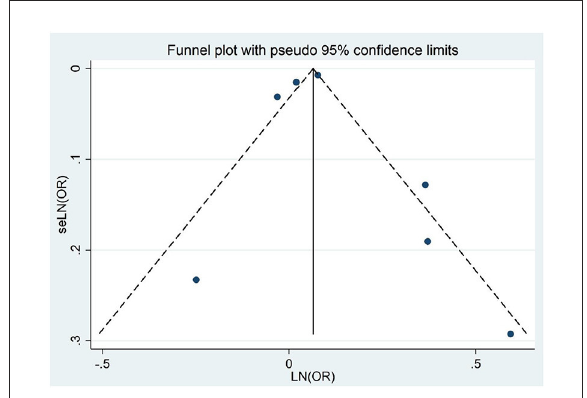
FIGURE6 Figure showing the effect of NAFLD on all-cause dementia and cognitive